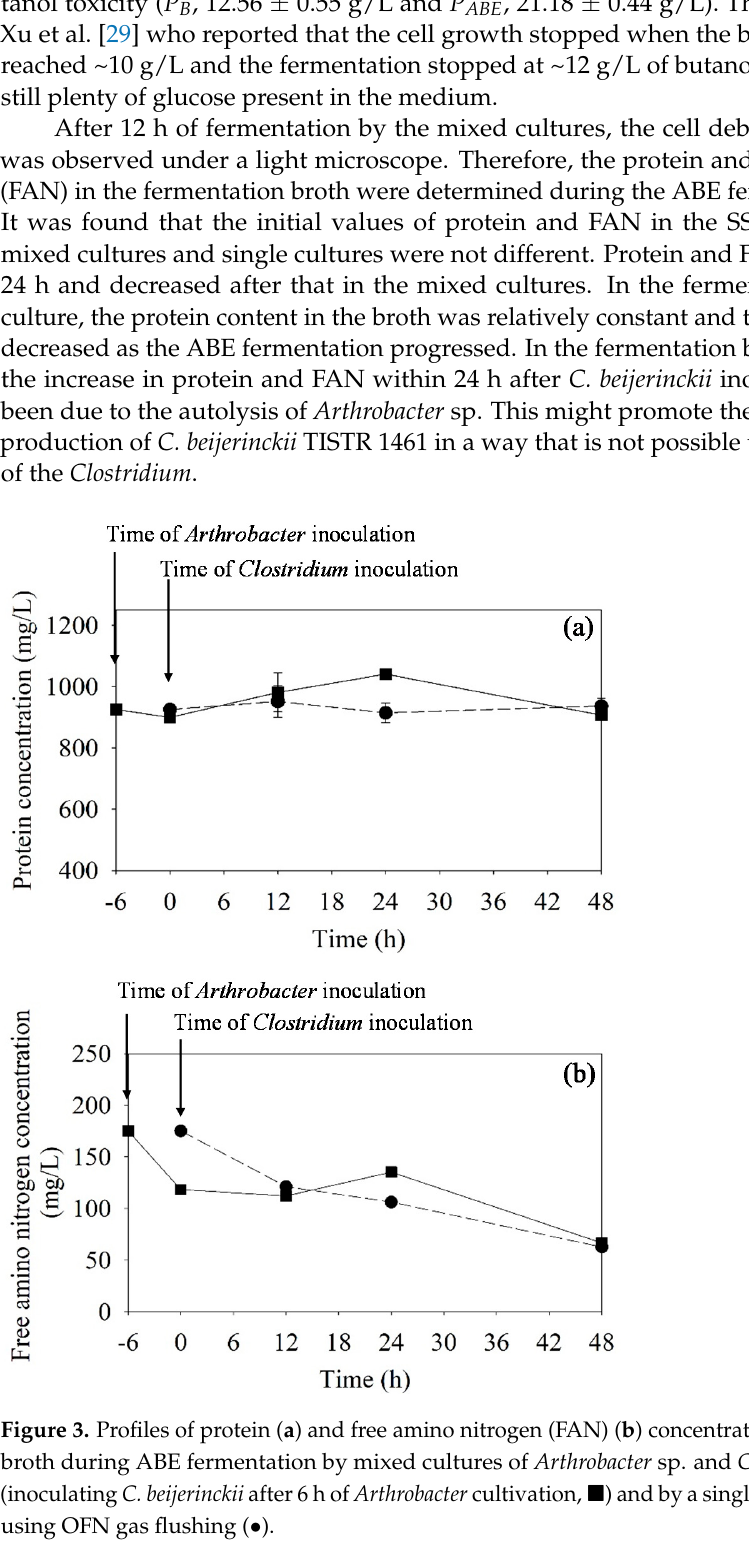
Table 1. Kinetic parameters of ABE fermentation by the mixed cultures of C. beijerinckii TISTR 1461 and Arthrobacter sp. BCC 72131 at different times of Arthrobacter sp. cultivation prior to C. beijerinckii inoculation and by a single culture of C. beijerinckii TISTR 1461 using OFN gas flushing.